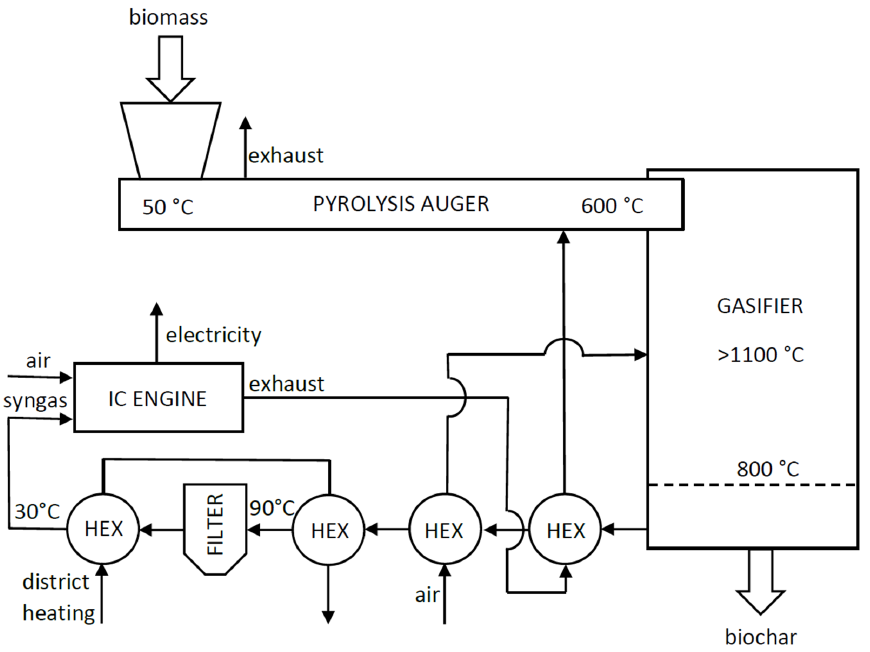
Figure 5. Viking gasifier with several heat exchangers (HEX) (adapted from [107]).